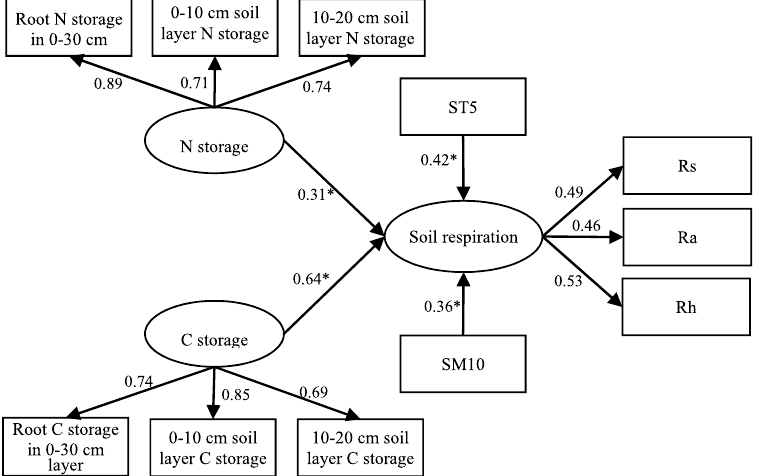
Figure 5. Structural equation model describing the influences of carbon and nitrogen storage, soil temperature at 5 cm depth and soil moisture content at 10 cm depth on growing season soil respiration and their relationships among each other. The rectangular boxes denote the observed variables, the ellipses denote latent variables. One-headed arrows indicate the relationships between variables. Numbers at arrows indicate standardized path coefficients or covariation coefficients. ST5: soil temperature at 5 cm depth; SM10: soil moisture content at 10 cm depth; Rs: total soil respiration; Ra: autotrophic respiration; Rh: heterotrophic respiration. * Indicates a significant difference at the 0.05 level.